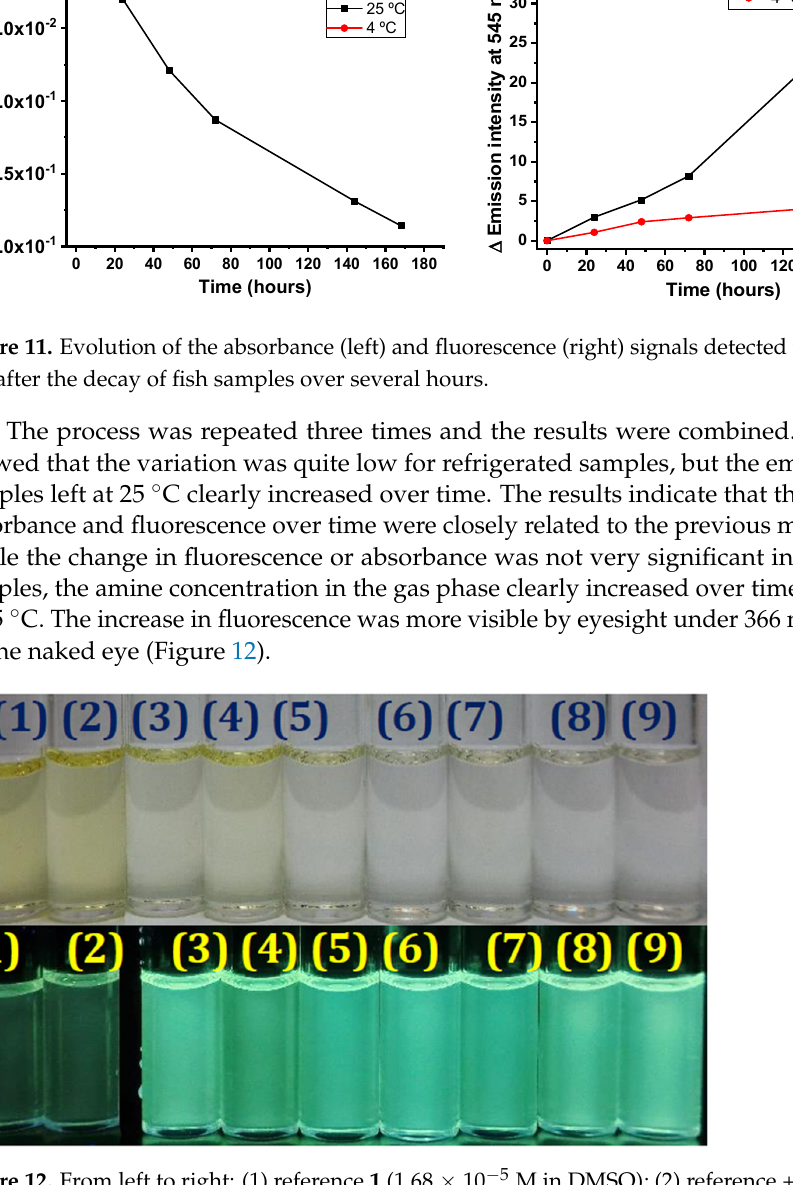
Figure 12. From left to right: (1) reference 1 (1.68 × 10 − 5 M in DMSO); (2) reference + air (bubbled); (3) reference + fish sample (bubbled) (3 days at 25 °C); (4) reference + fish sample (bubbled) (1 day at 25 °C); (5) reference + histamine (bubbled); (6) reference + putrescine (bubbled); (7) reference + cadaverine (bubbled); (8) reference + pyrrolidine (bubbled); (9) reference + all amines (bubbled). (Top) Under visible light; (Bottom) under UV light (366 nm).